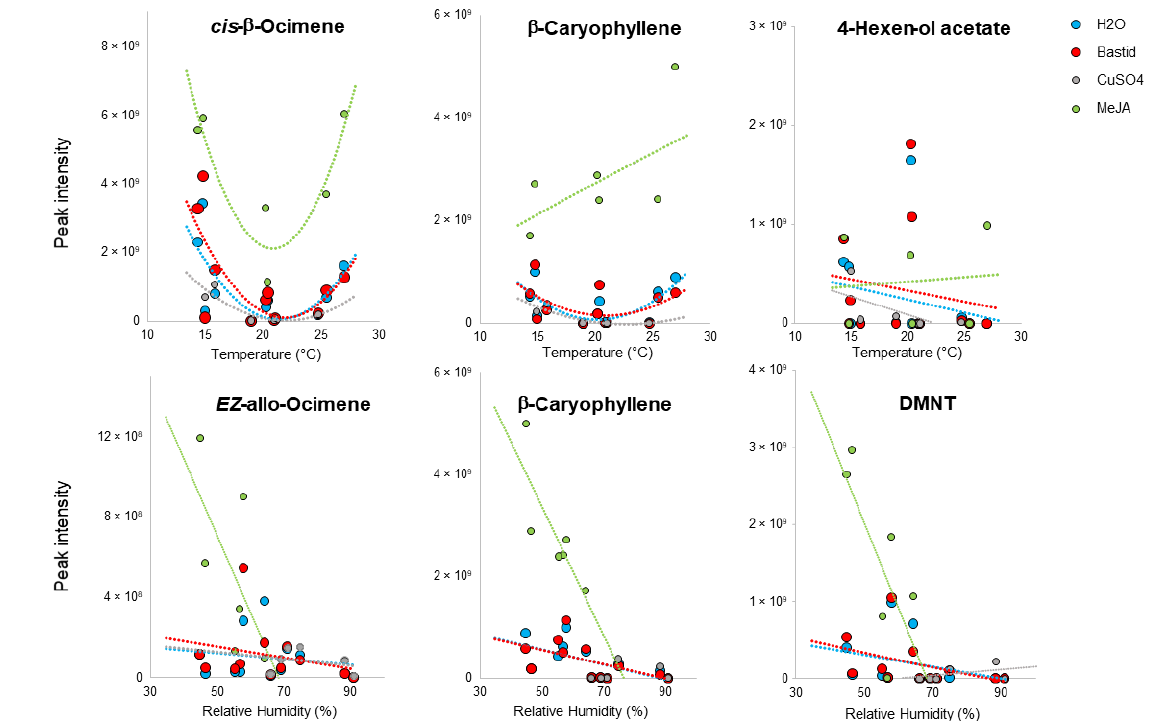
Figure 7. Impact of mean temperature and relative humidity on the detection of targeted monoter- penes, sesquiterpenes and “Other VOCs” induced by elicitors. The graphs were built from 2019 data. Grapevine emission of terpenes analysed three- and five-days post treatment with H 2 O (control) or an elicitor of plant defence (Bastid ® , MeJA or CuSO 4 ) at three phenological stages of grapevines (pre-blossom, fruit-set, bunch-closure) in Burgundy (cv. Chardonnay) and Bordeaux (cv. Cabernet franc) vineyards. Values correspond to VOC peak intensities and the shapes of the tendency curves were chosen to best fit the point values.